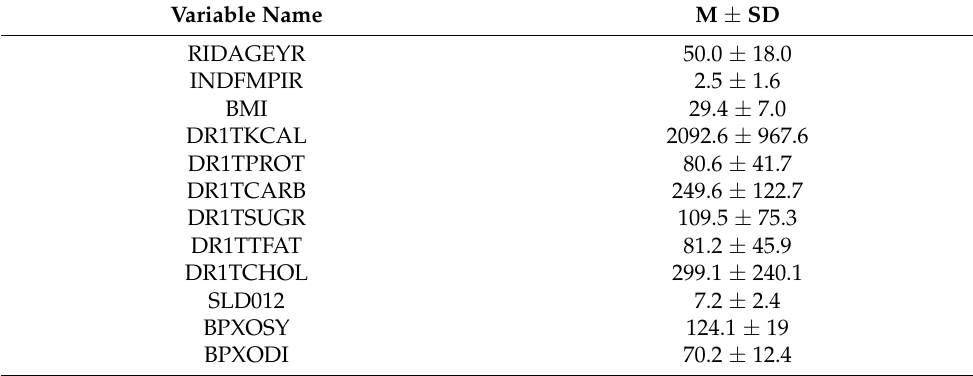
Table 3. Descriptive analysis of continuous data (mean ± standard deviation).